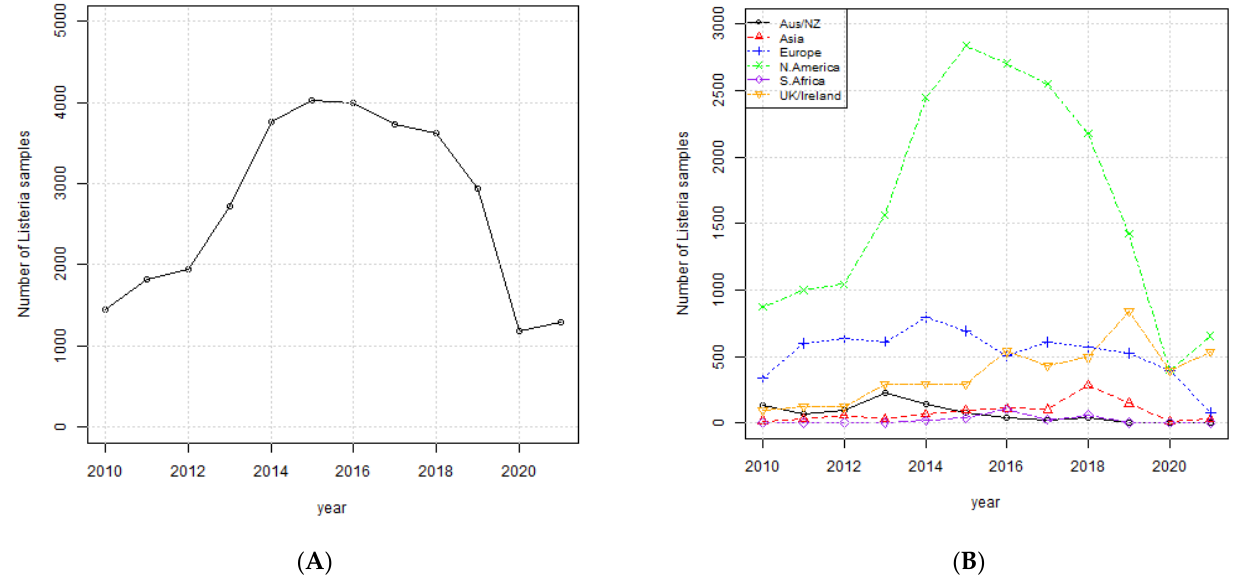
Figure 1. ( A ) Total number of L. monocytogenes samples per year; ( B ) L. monocytogenes samples per region per year.